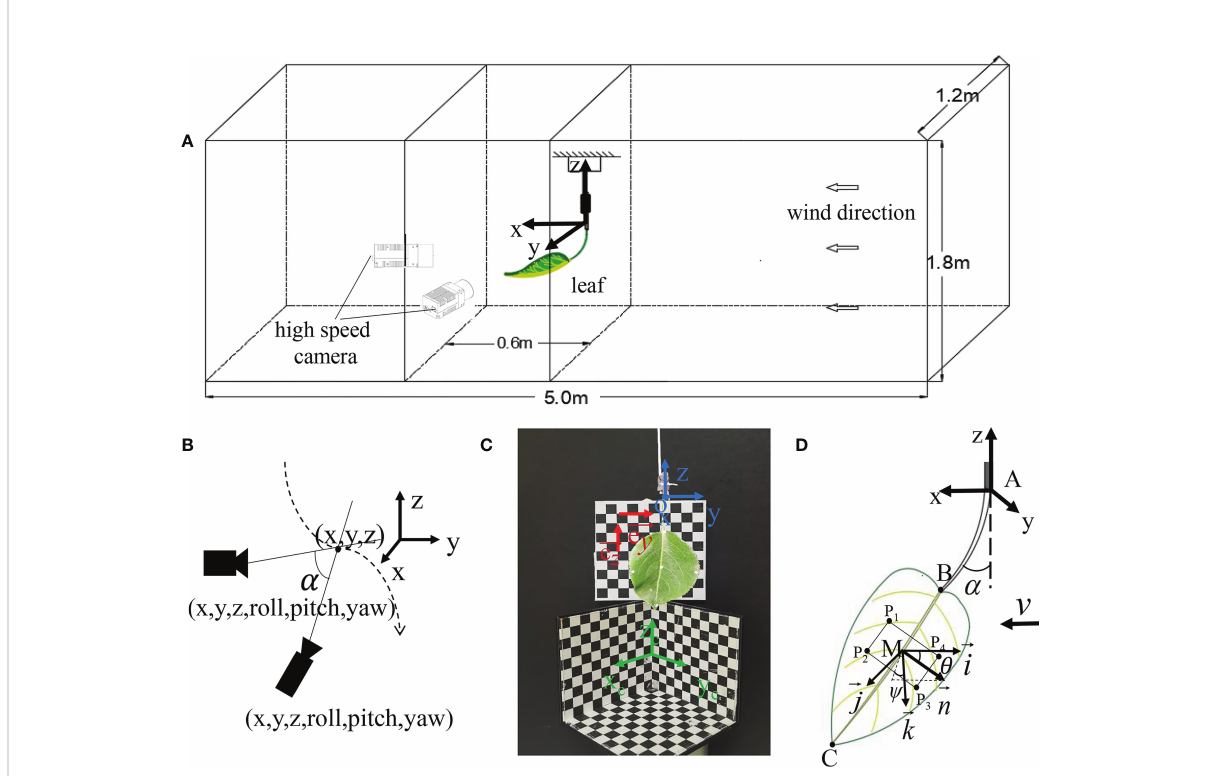
FIGURE 3 Test devices and settings : (A) Schematic diagram of the test sample and camera placement in a wind tunnel; (B) Schematic diagram of video measurement; (C) Coordinate calibration; (D) Schematic of the tracking point and different